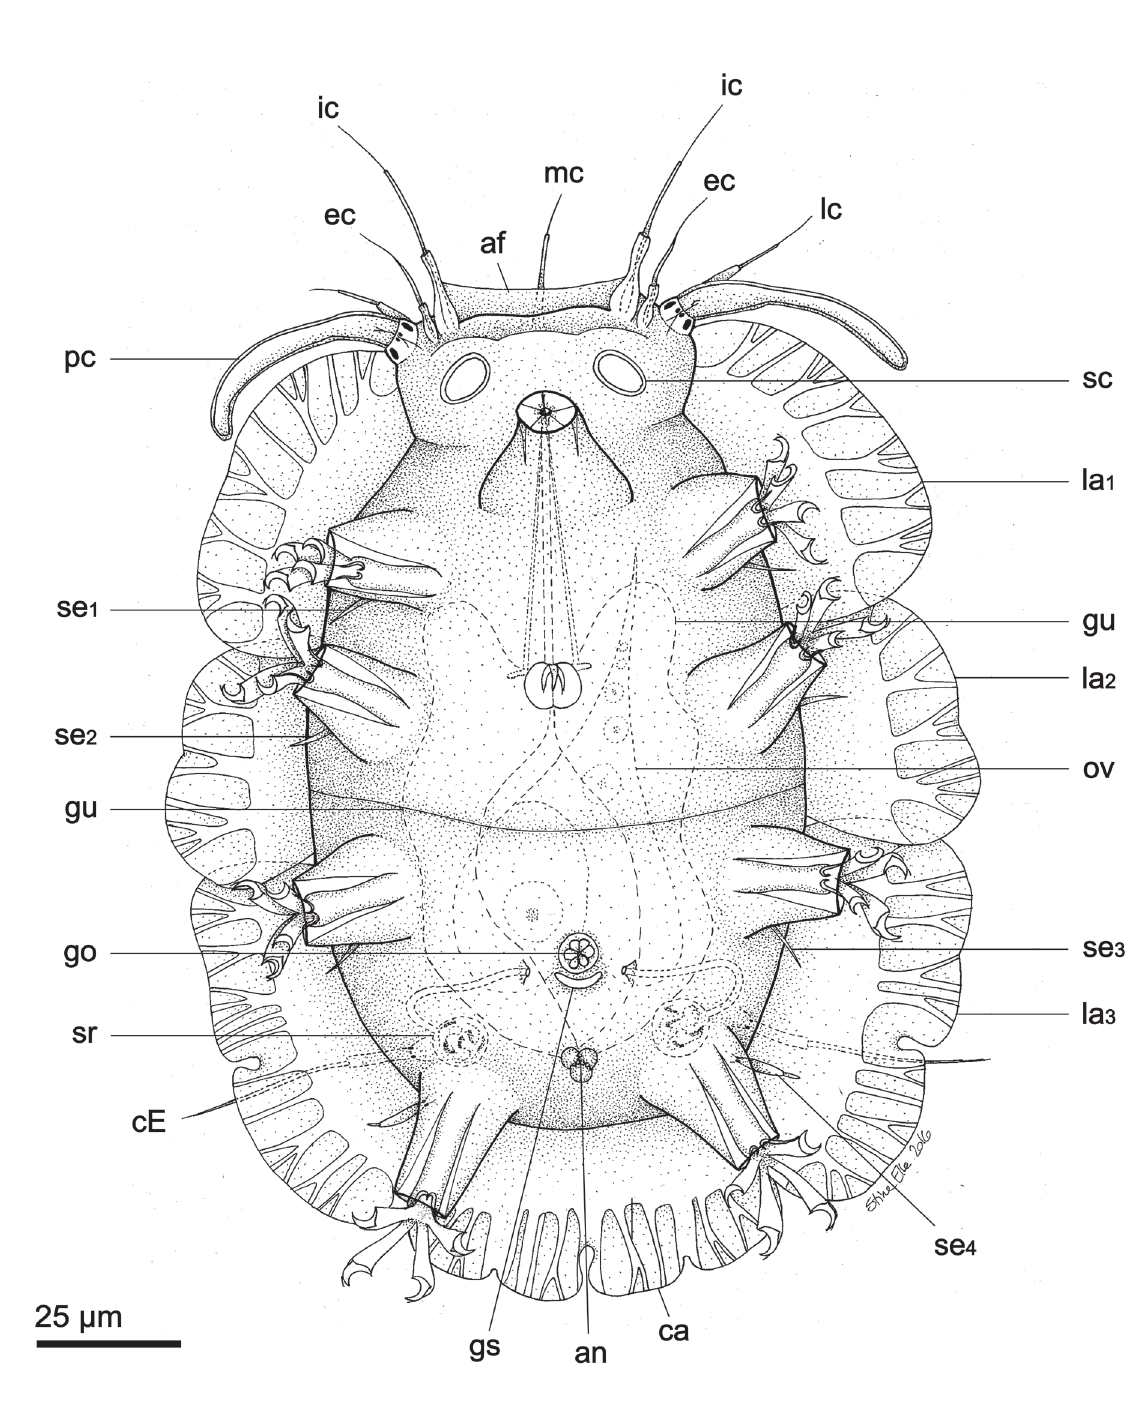
Fig. 10. Higginsarctus lassei gen. et sp. nov., holotype, ♀ (NHMD-293913). Ventral overview. Abbreviations: see Material and methods. Drawing by Stine B.